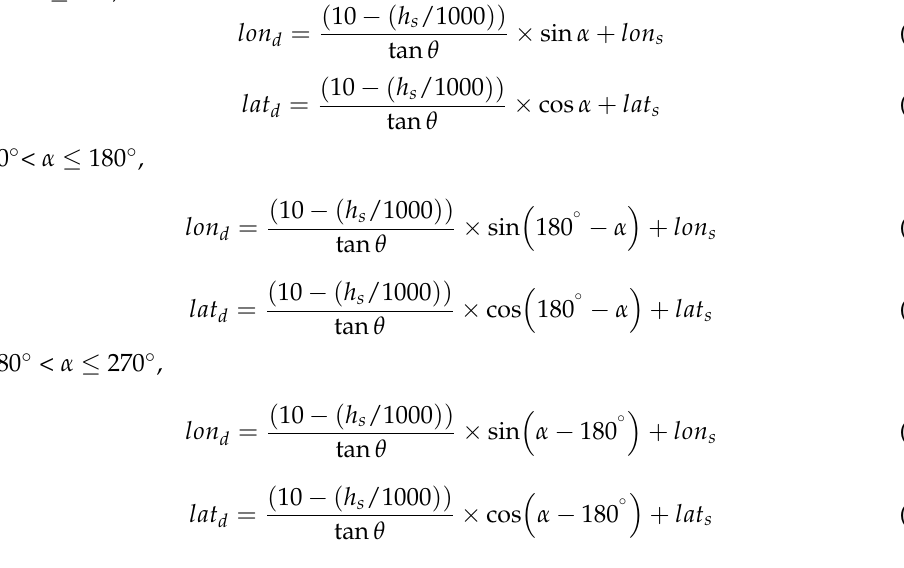
Figure 1. Distribution of tomography stations. Second, generate a 4 × 4 × 20 basic grid with the station in the middle position as the origin. In the horizontal direction, the area of 2 ◦ × 2 ◦ is divided into 4 × 4 uniform grids, and in the vertical direction, the 10 km is divided into 20 layers evenly. Then, the coordinates of the intersection point between the signal line and the top layer of the model were calculated based on the relative coordinates of each station and the satellite elevation and azimuth angles. Assuming that the elevation angle of the satellite is θ , the azimuth angle is α , the wgs84 coordinates of the station are lon s , lat s , h s , and the intersection point of the satellite ray and the ceiling of the model are lon d , lat d , h d .